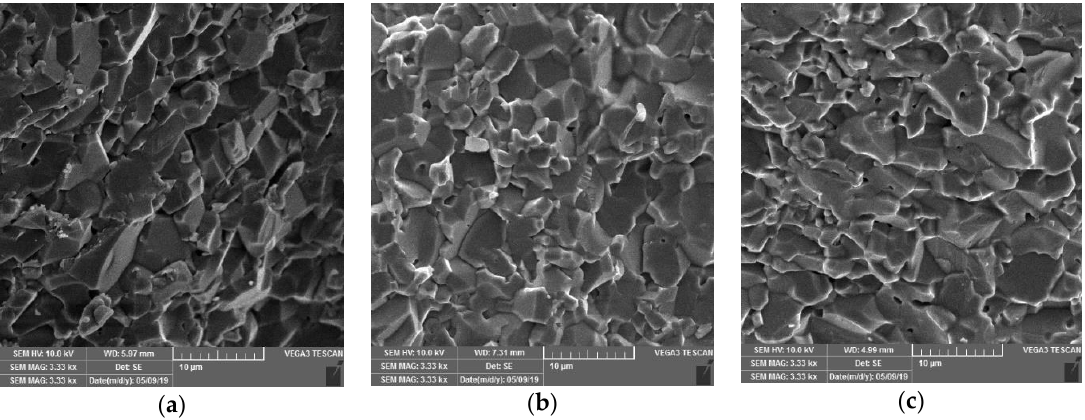
Figure 3. SEM images of alumina morphology sintered at 1550 °C with fixed weight ratios of waste alumina powder of 20 wt.%, 0.05 wt.% Tiron and 0.1 wt.% PVA and with varying amounts of magnesium aluminate spinel: ( a ) 0.2 wt.% MgAl 2 O 4 , ( b ) 0.6 wt.% MgAl 2 O 4 and ( c ) 1.0 wt.% MgAl 2 O 4 expressed on dry weight basis.